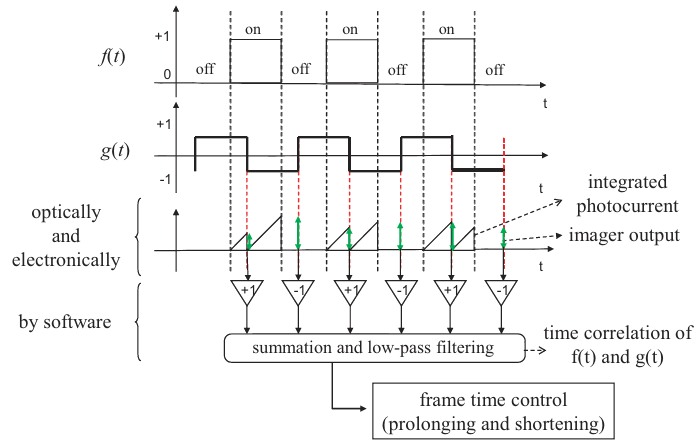
Figure 6. Procedure of the proposed time-correlation